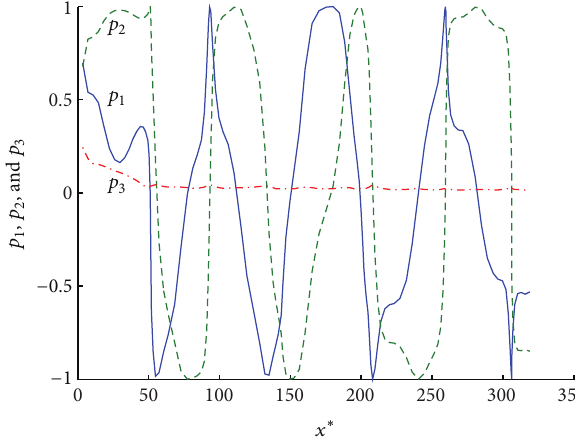
Figure7:Componentsofthefiberorientationvectoralongthesame sample Lagrangian trajectory as used in Figure